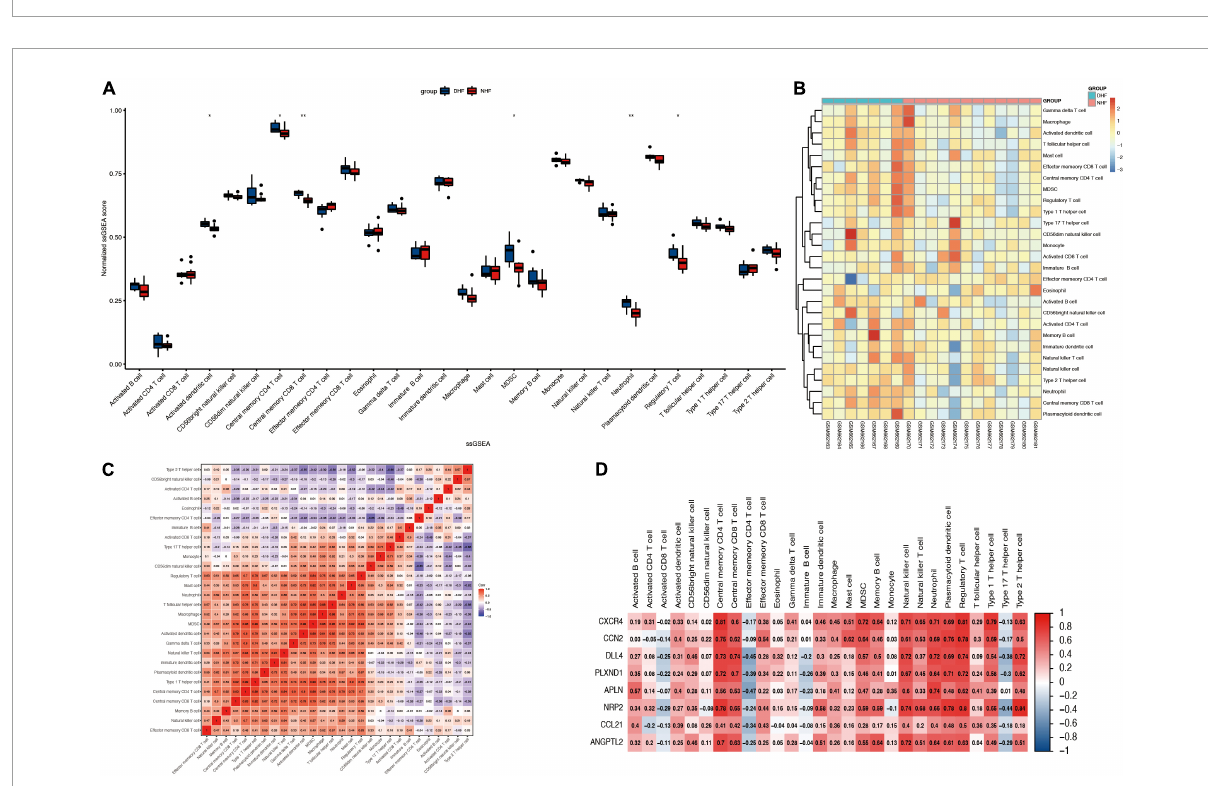
FIGURE5 Immune infiltration in myocardial fissure. (A) Relative ssGSEA score of 28 immune cells. (B) Distribution of immune cells in each sample. (C) Correlation analysis between immune infiltrating cells. (D) Correlation analysis between immune infiltrating cells and immune related genes. * P < 0.05; ** P < 0 .